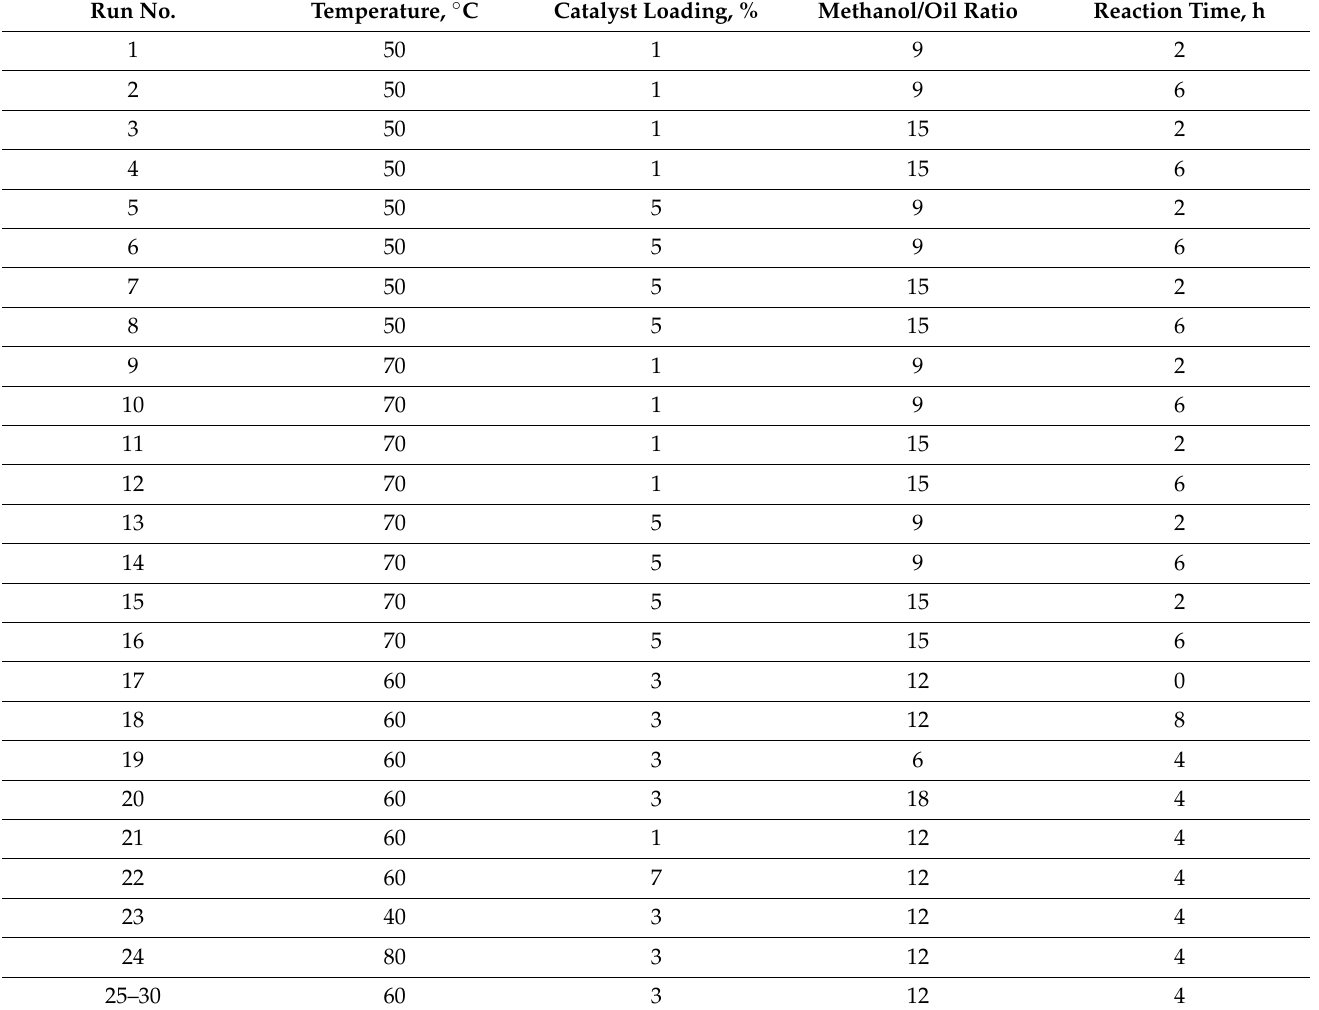
Table 7. Biodiesel experimental